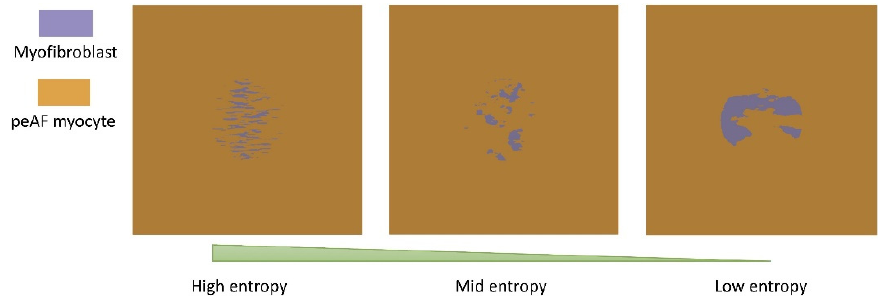
Figure 5. Three different fibrosis patterns with clustering of the myofibroblast infiltration in the central part of the tissue for a density of 20%. From left to right, patterns that resemble interstitial to patchy fibrosis.